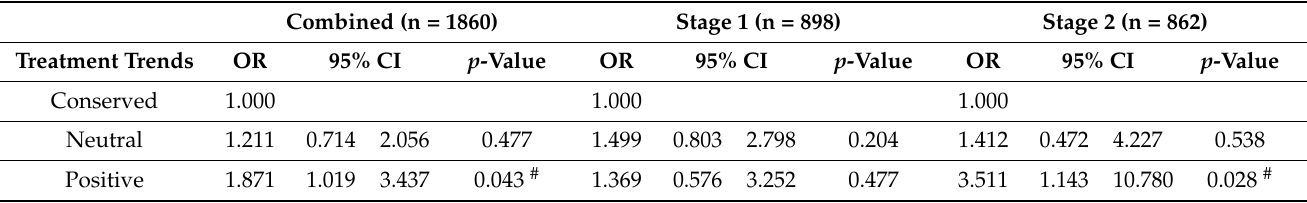
Table 5. The relationship between antiplatelet therapy and in-hospital recurrence in noncardiac stroke patients in different stages.